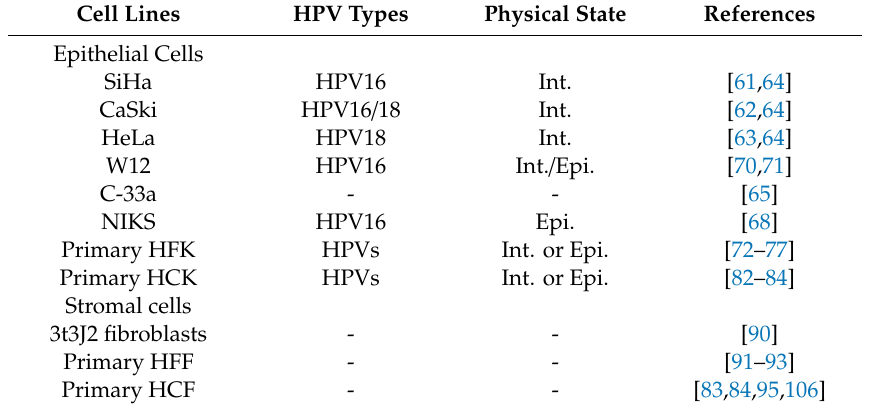
Table 1. Summary of di ff erent cell types used to develop tissue engineered cervical